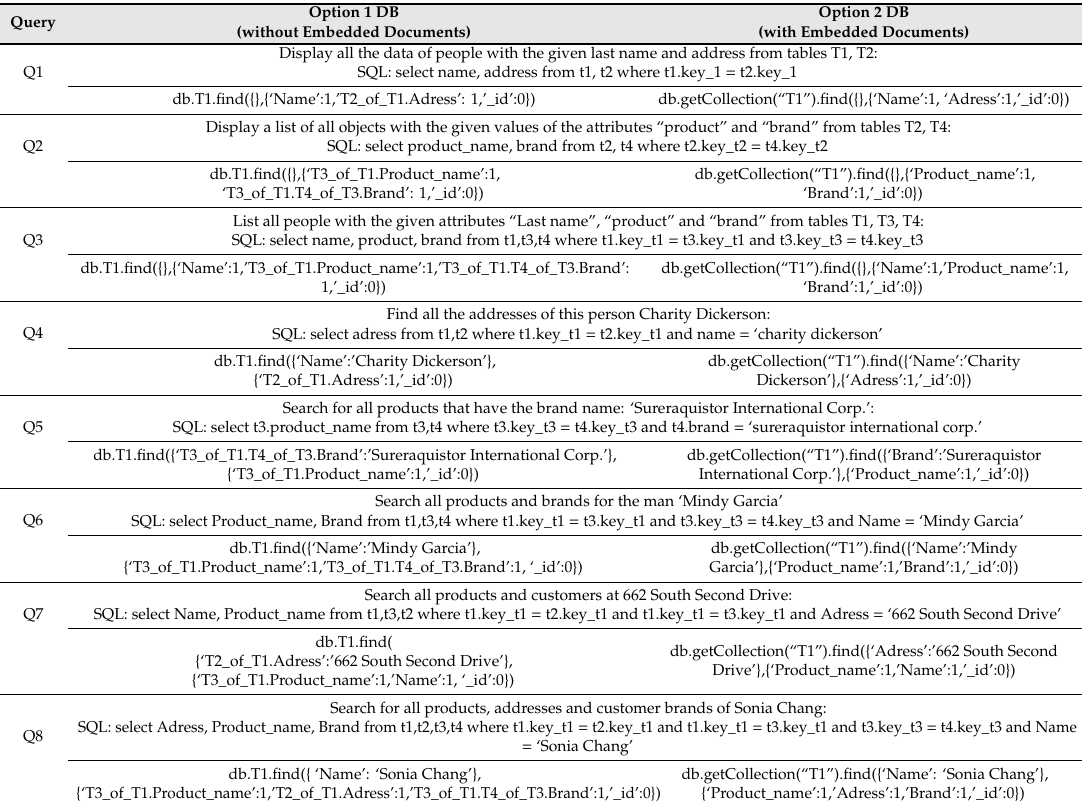
Table A1. Schematic representation of a document in a document database composed of attributes corresponding to the fields of di ff erent